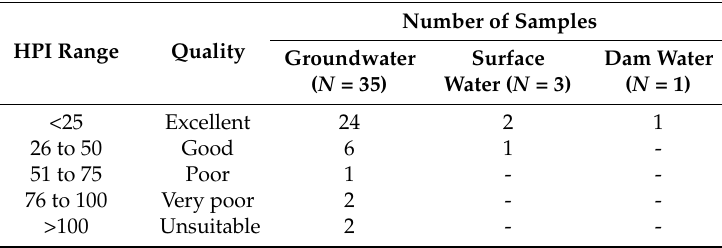
Table 3. Classification of water based on heavy metal pollution index